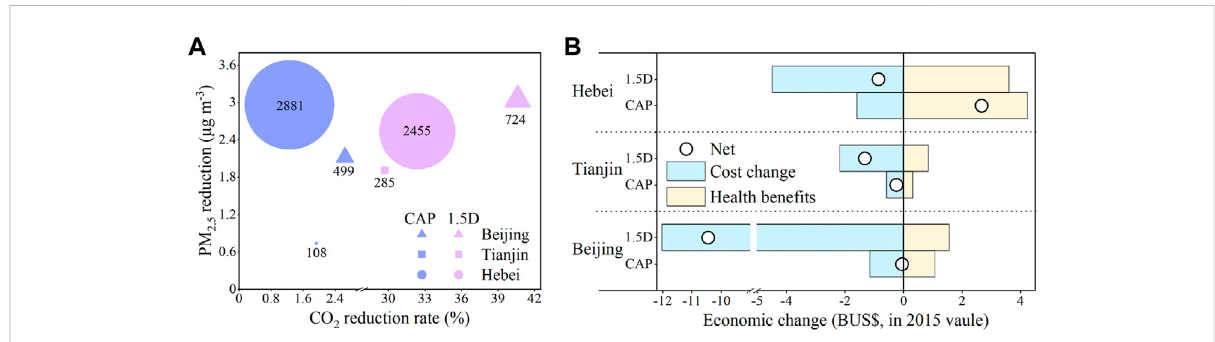
FIGURE 7 (A) Co-bene fi t of CO 2 emission reduction and air quality improvement in CAP and 1.5D scenario relative to REF, the size of the geometrical shaperepresentstheavoidedprematuredeathscomparedwithREF. (B) Economicbene fi tsofbothairquality-relatedhealthbene fi tsanddecreasing CO 2 emissions in two scenarios in three